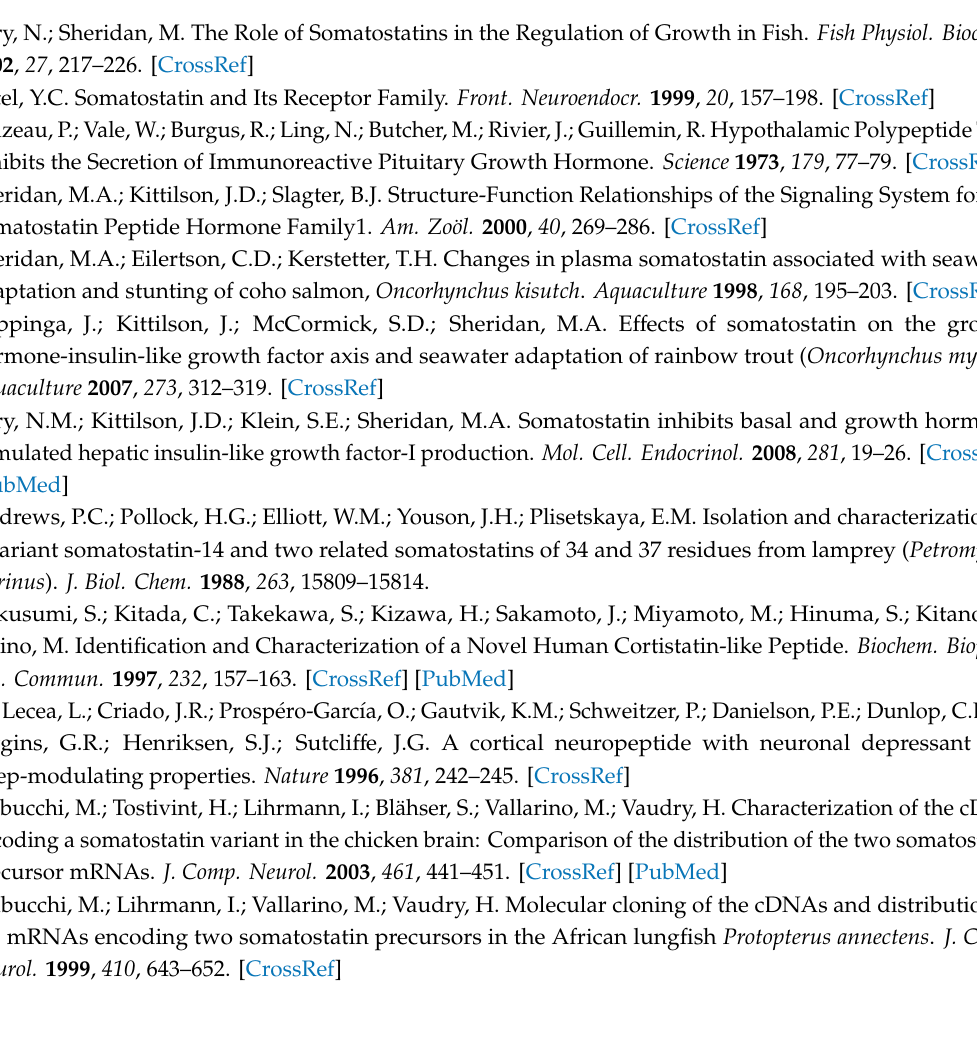
Figure S1. Nucleotide and deduced amino acid sequences of S. argus SSTs; Figure S2. Comparison of SST amino acid sequences between S. argus and other species; Figure S3. The cDNA structure of four SST genes from S. argus ; Table S1. Primers targeting SST genes for cloning and detection of expression; Table S2. Sequence